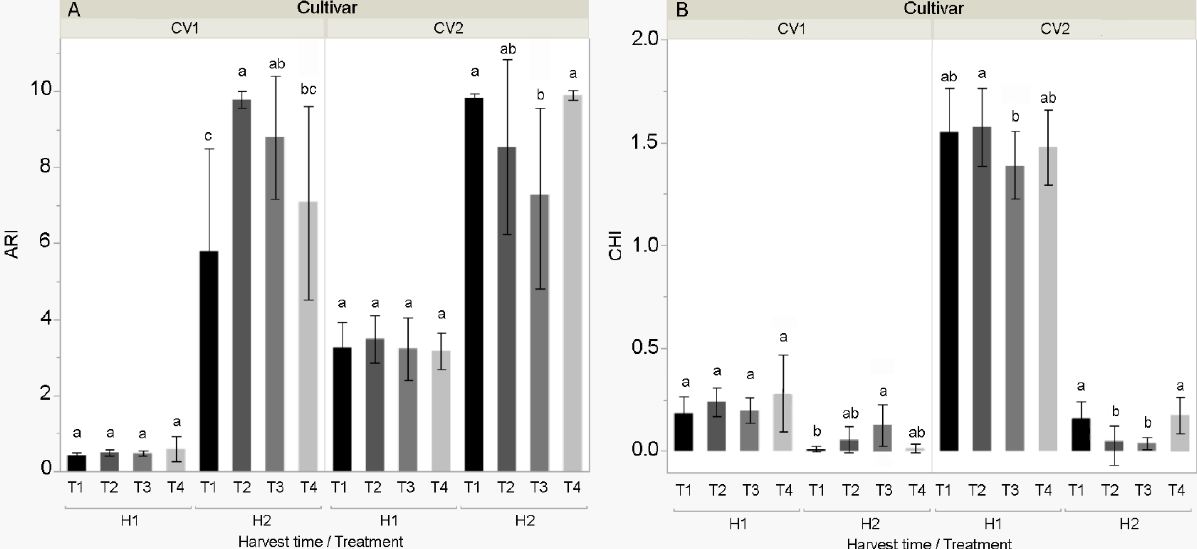
Figure 6. Selected multispectral fruit properties ( A ) anthocyanin index (ARI) and ( B ) chlorophyll index (CHI) of sweet pepper cultivars CV1 (Šorokšari) and CV2 (Kurtovska kapija) fruits in H1 (first harvest at technological maturity) and H2 (second harvest at physiological maturity). The T1 (control), T2 (Eco Green, calcite nanoparticles at lower concentration), T3 (Eco Green, calcite nanoparticles at higher concentration) and T4 (Zeogreen+P, calcite-based foliar fertilizer) were applied three times during vegetation on sweet pepper plants. Post hoc comparisons of the means were performed using Tukey’s HSD test at p < 0.05; different letters indicate significant differences among treatments within each measurement time.